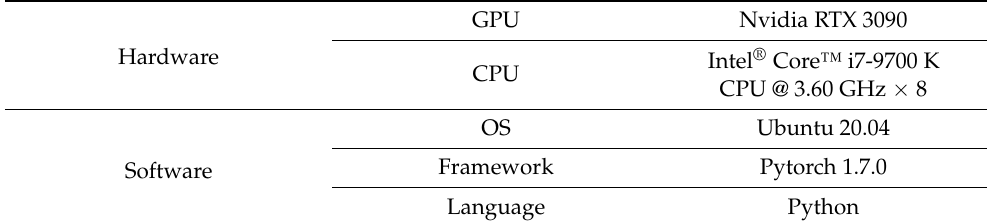
Table 1. Experimental